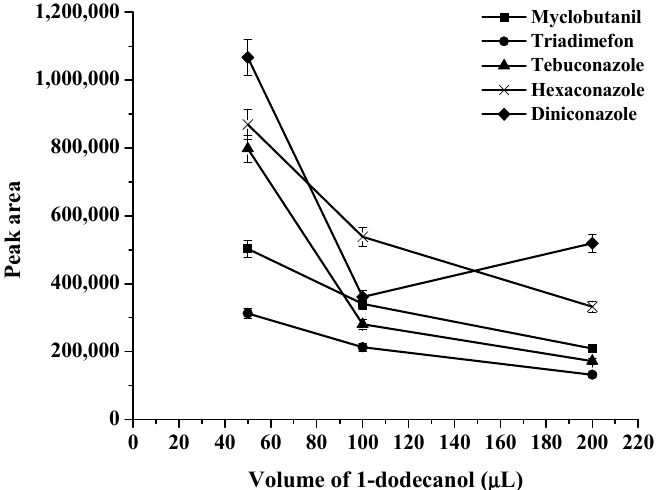
Figure 5. Effect of volume of 1-dodecanol on extraction efficiency. To evaluate the salt effect on the efficiency of the in situ extraction procedure, various tests were carried out using different concentrations of salt in the range of 0–10% ( w/v ) NaCl (data not shown). The results indicated that by increasing NaCl from 0 to 5% ( w/v ), the peak area of triazoles remained nearly constant. At higher percentages, the analytical signal of the analytes decreased due to the dilution effect. Therefore, the experiments were carried out in the absence of any salt.